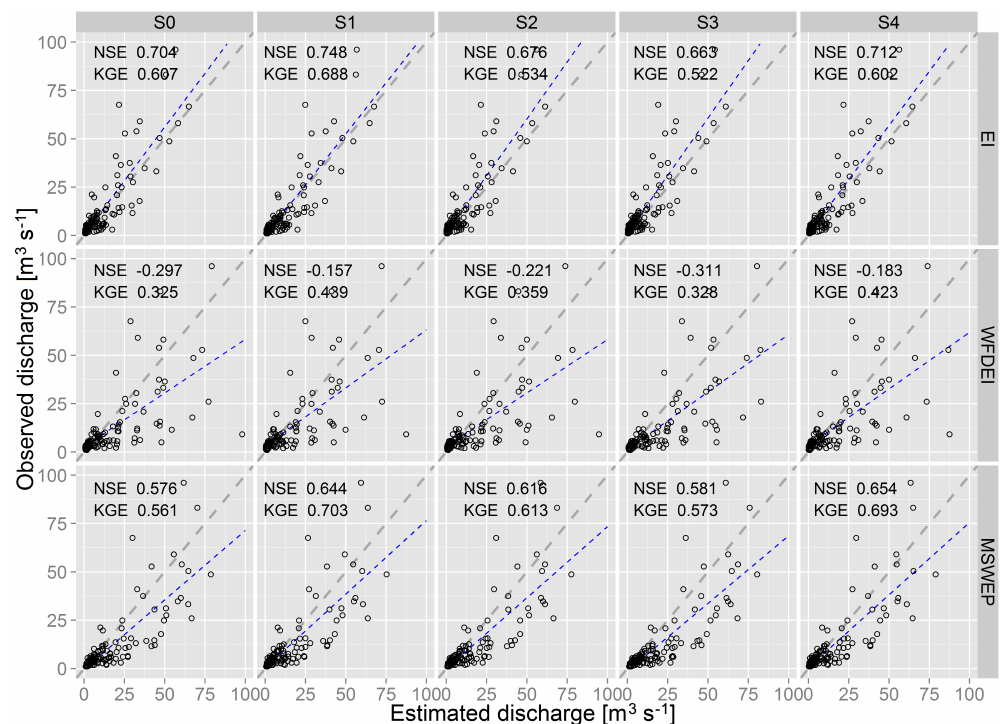
Figure 6. Scatter plots of monthly estimated discharge ( x axis) and observed discharge ( y axis) at Mechra Eddahk. Rows indicate the three global precipitation products and columns indicate the five calibration